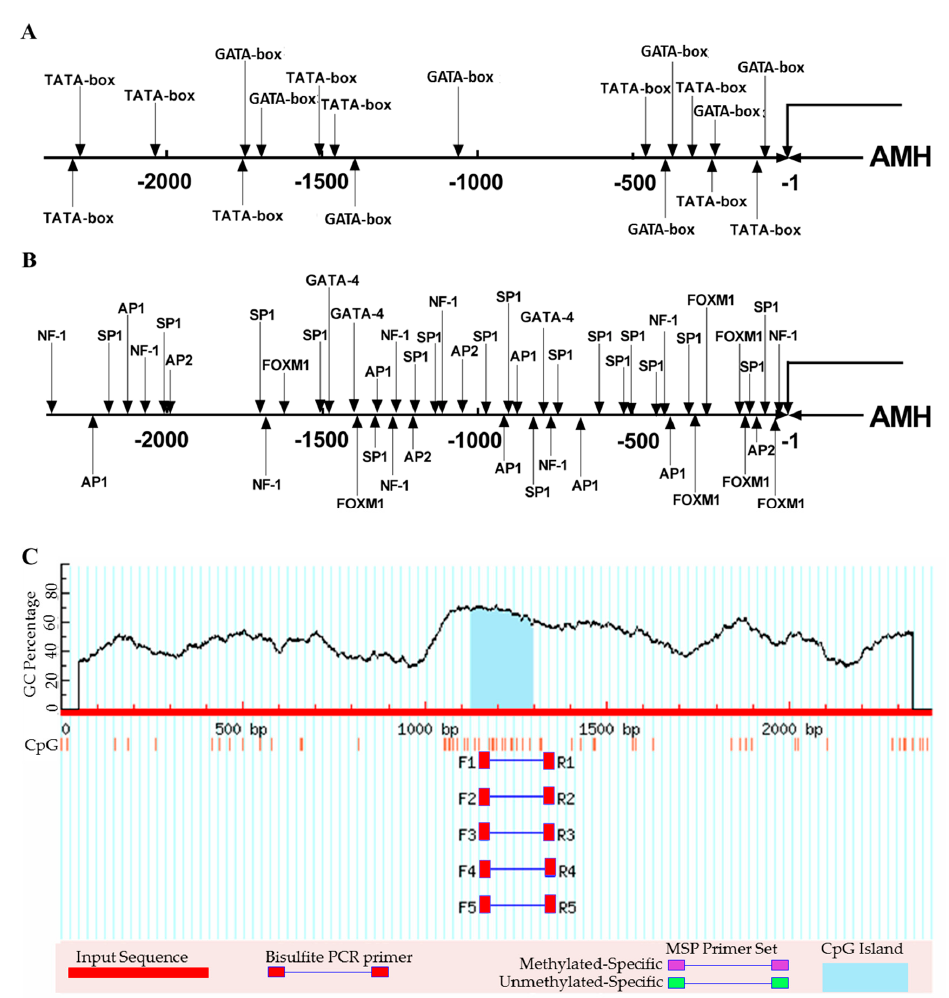
Figure 3. Analysis of the promoter region of AMH gene in geese. ( A ) The prediction of core promoter elements in 5 ′ -flanking region of goose AMH gene. ( B ) The prediction of transcription factors in 5 ′ -flanking region of goose AMH gene. The line represented the AMH promoter region and ‘ − 1 ′ represented the translation initial site ‘ATG.’ The number below the line represented the positions of promoter sequence. The arrows represented the positions of core promoter elements and transcription factors, respectively. ( C ) The prediction of CpG island of goose AMH . There was a CpG island being predicted. Table 1. The prediction results of AMH gene core transcriptional promoter region in geese.